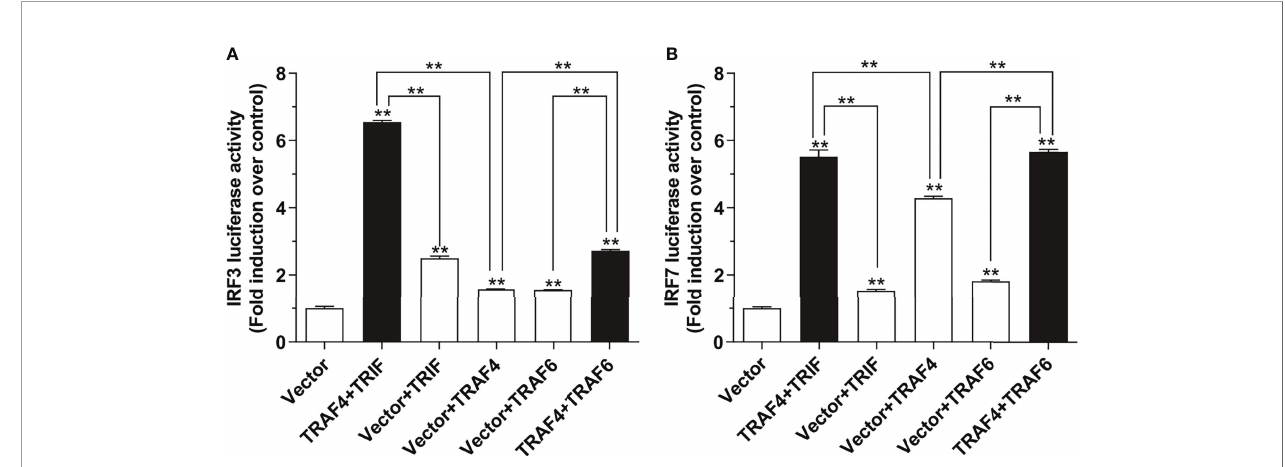
FIGURE 7 | Lc -TRAF4 associated with Lc -TRIF and Lc -TRAF6 in IRF3 and IRF7 promoter activation. (A) The association of Lc -TRAF4 with Lc -TRIF and Lc -TRAF6 in IRF3 promoter activation. (B) The association of Lc -TRAF4 with Lc -TRIF and Lc -TRAF6 in IRF7 promoter activation. HEK 293T cells were co-transfected with 100 ng of pGL4-IRF3-pro or pGL4-IRF7-pro, 10 ng of pRL-TK together with 100 ng of pcDNA3.1-TRAF4, pcDNA3.1-TRIF and pcDNA3.1-TRAF6 alone or in a combination of two. The pcDNA3.1 empty vector was added to balance the total amounts of transfected plasmids between different wells. At 24 hpt, the cells were harvested for the detection of luciferase activities. All data were presented as mean ± SE from three independent experiments, with bars representing SE. * P < 0.05, ** P <